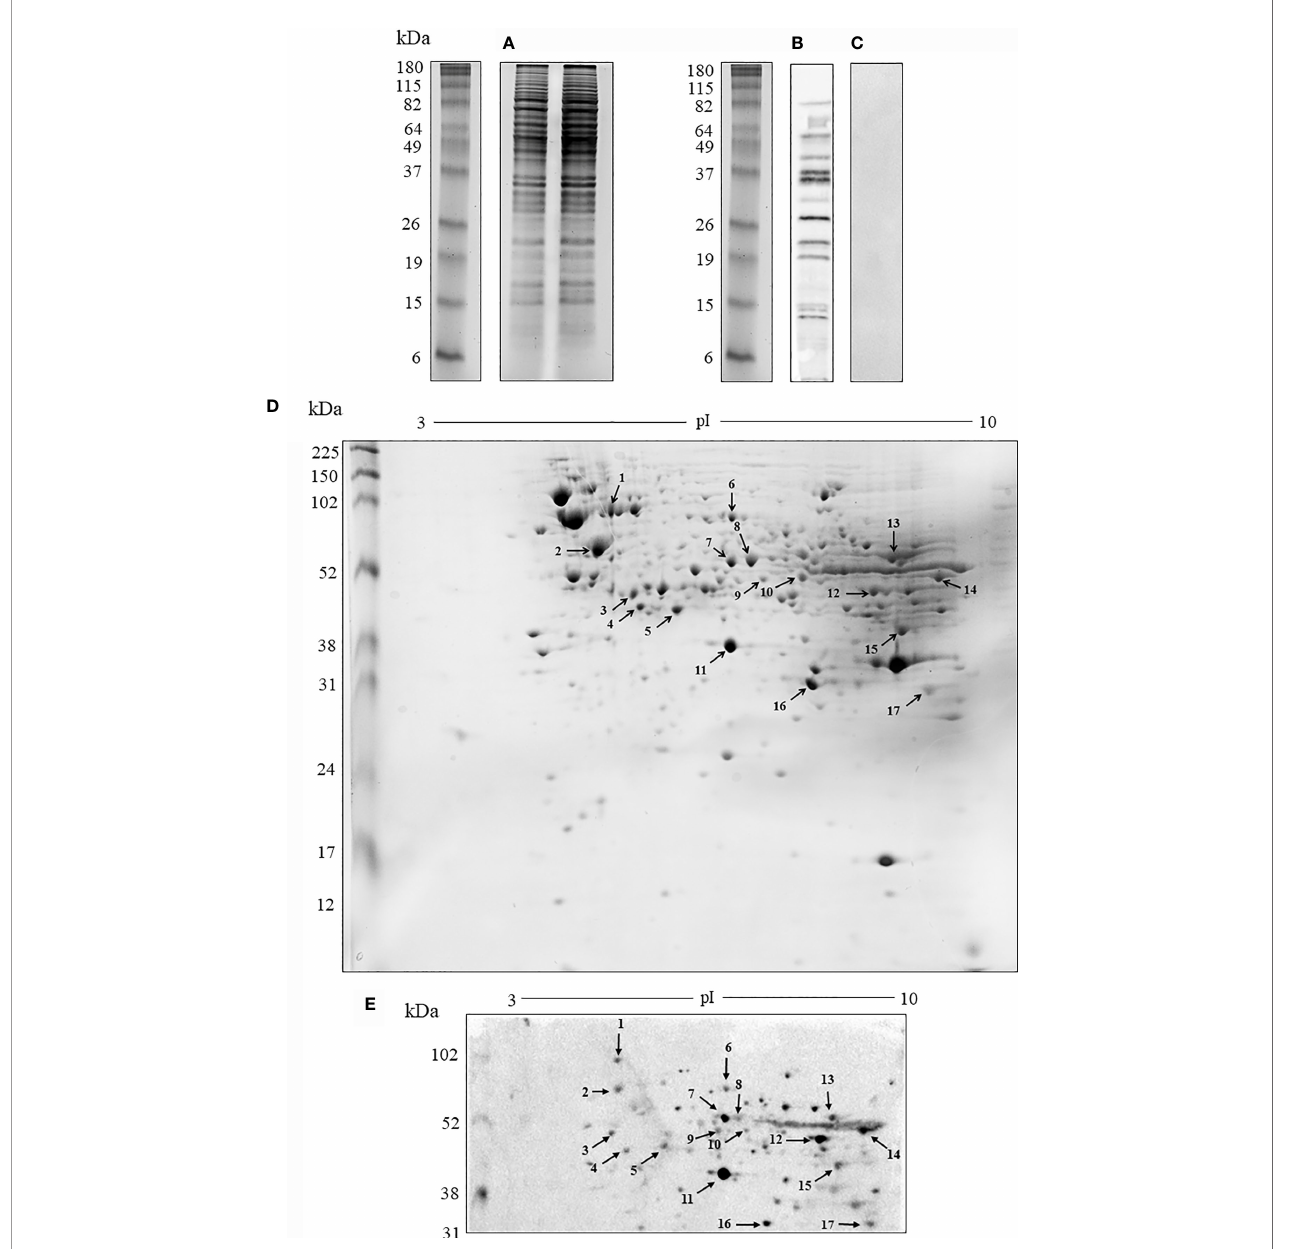
FIGURE 1 | Analysis of the protein and antigenic pro fi le of ( H ) capsulatum . (A) Electrophoretic pro fi le by 1-D SDS-PAGE of protein extract. (B) Antigenic pro fi le by immunoblotting the protein extract resolved in 1-D gel with sera from mice immunized with the protein extract. (C) 1-D gel control with serum from non-immunized animals. (D) Electrophoretic pro fi le by 2-D SDS-PAGE of protein extract. The arrows indicate spots that have been excised and subjected to mass spectrometry. (E) Antigenic pro fi le by immunoblotting of the protein extract with sera from mice immunized with the protein extract resolved in 2-D gel. The 1-D SDS-PAGE was also performed before each 2-D SDS-PAGE experiment to ensure the quality of protein extracts. The results are representative of the biological triplicates. Electrophoresis stained with Coomassie blue. kDa,